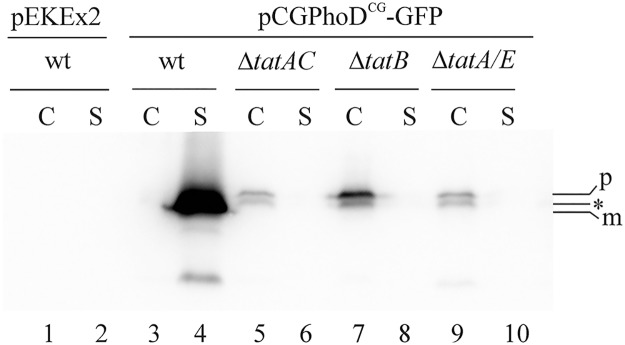
Analysis of PhoDCG-GFP secretion in C. glutamicum wild-type and tat mutant strains.Cultures of C. glutamicum strains expressing the Tat-dependent PhoDCG-GFP model protein [35] were fractionated into cells (C) and supernatant (S). Samples of the fractions corresponding to an equal number of cells (i.e. an OD600 of 1.0) were subjected to SDS-PAGE and immunoblotting using GFP-specific antibodies. The following strains were analyzed: C. glutamicum wild-type (wt) containing the empty vector pEKEx2 as negative control (lanes 1 and 2), C. glutamicum wild-type (wt) containing plasmid pCGPhoDCG-GFP (lanes 3 and 4), and the pCGPhoDCG-GFP-containing C. glutamicum mutant strains ΔtatAC (lanes 5 and 6), ΔtatB (lanes 7 and 8), and ΔtatA/E (lanes 9 and 10). p: PhoDCG-GFP precursor; asterisk: cytosolic degradation product; m: mature-sized GFP protein.